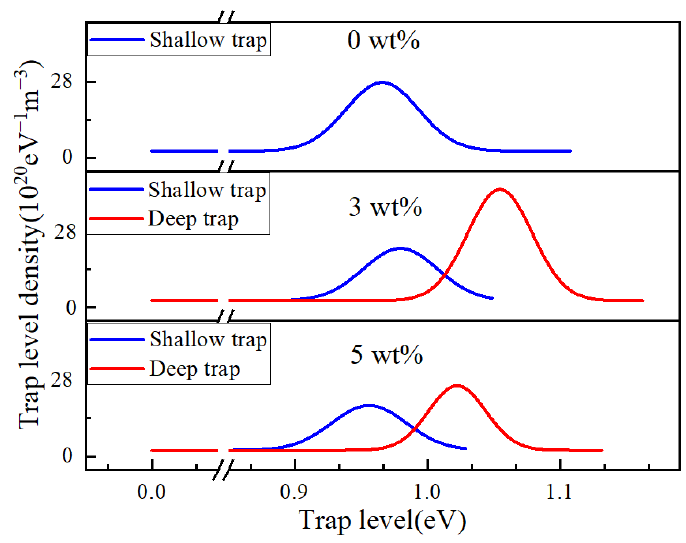
Figure 6. The electron traps distribution spectrum of different nanofiller contents of EP/GO.